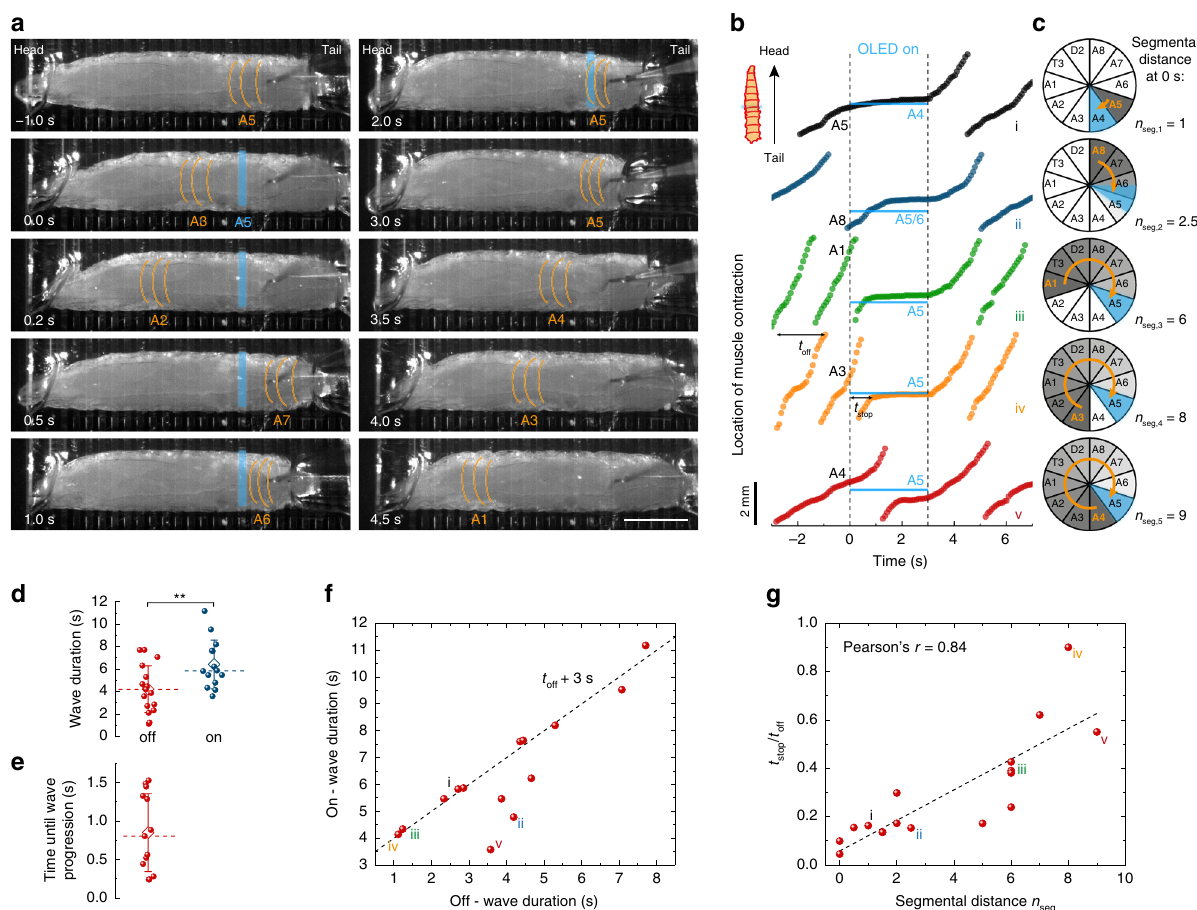
Fig. 5 Local optical halting of muscle contraction waves upon sensory neuron activation in CsChrimson-expressing larvae. Larvae were stimulated at posterior segments A3 – A7 with one OLED pixel at a light intensity of 15 µ W mm − 2 for 3 s. a Representative time lapse indicating the active larval segment with orange lines in each frame. Active OLED pixel located at A5 as indicated in blue. Scale bar: 1 mm. See Supplementary Movie 4 for complete time lapse and trace iv (orange) in b for further analysis. b Location of forward muscle contraction waves over time. The location of the active OLED and of the illuminated larval segment is indicated in blue. The segment that was contracted at the time of light turn-on (at 0 s) is indicated in black. Data shown were collected from four different larvae. c Polar graphs illustrate the progress of muscle contraction waves between the time of OLED turn-on and the wave coming to a local halt. The contracted segment at OLED turn-on marked in orange; illuminated segment marked in blue. Segmental distance, n seg , represents the number of segments between the segment contracted at the time of light turn-on and the stimulated segment. d Statistical comparison of wave duration for OLED off and on. During on-time, wave durations were signi fi cantly longer ( P = 0.008, two-tailed t test) than during off-time. Whiskers: SD; diamond: mean; dashed line: median. e Statistical analysis of time elapsed between light turn-off and the progression of the muscle contraction wave. f Relation between durations of contraction wave under illumination, t on , and in the dark, t off . Dashed line: t on = t off + 3 s. g Time that elapsed between light turn-on and pausing of muscle contraction wave, t stop , over t off as a function of n seg ( n seg as de fi ned in c ). Roman numbers i – v in f and g indicate the corresponding graphs in b . n = 6 larvae with ≥ 13 stimulations for d – g